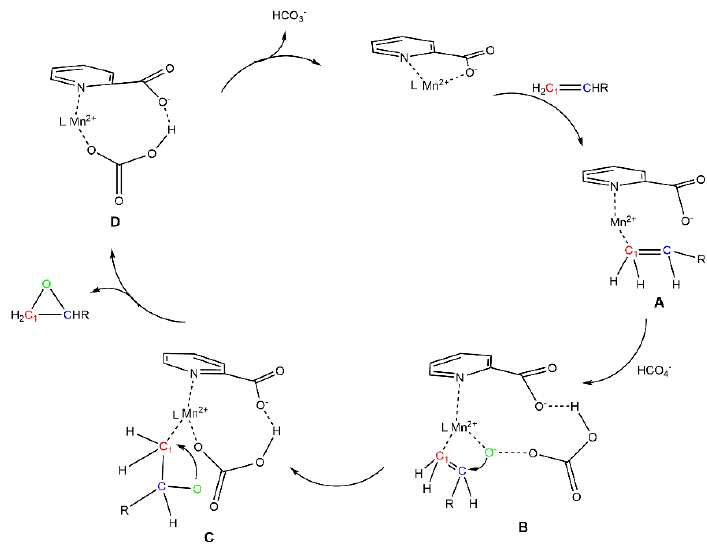
Scheme 1. The possible mechanism for catalytic epoxidation of